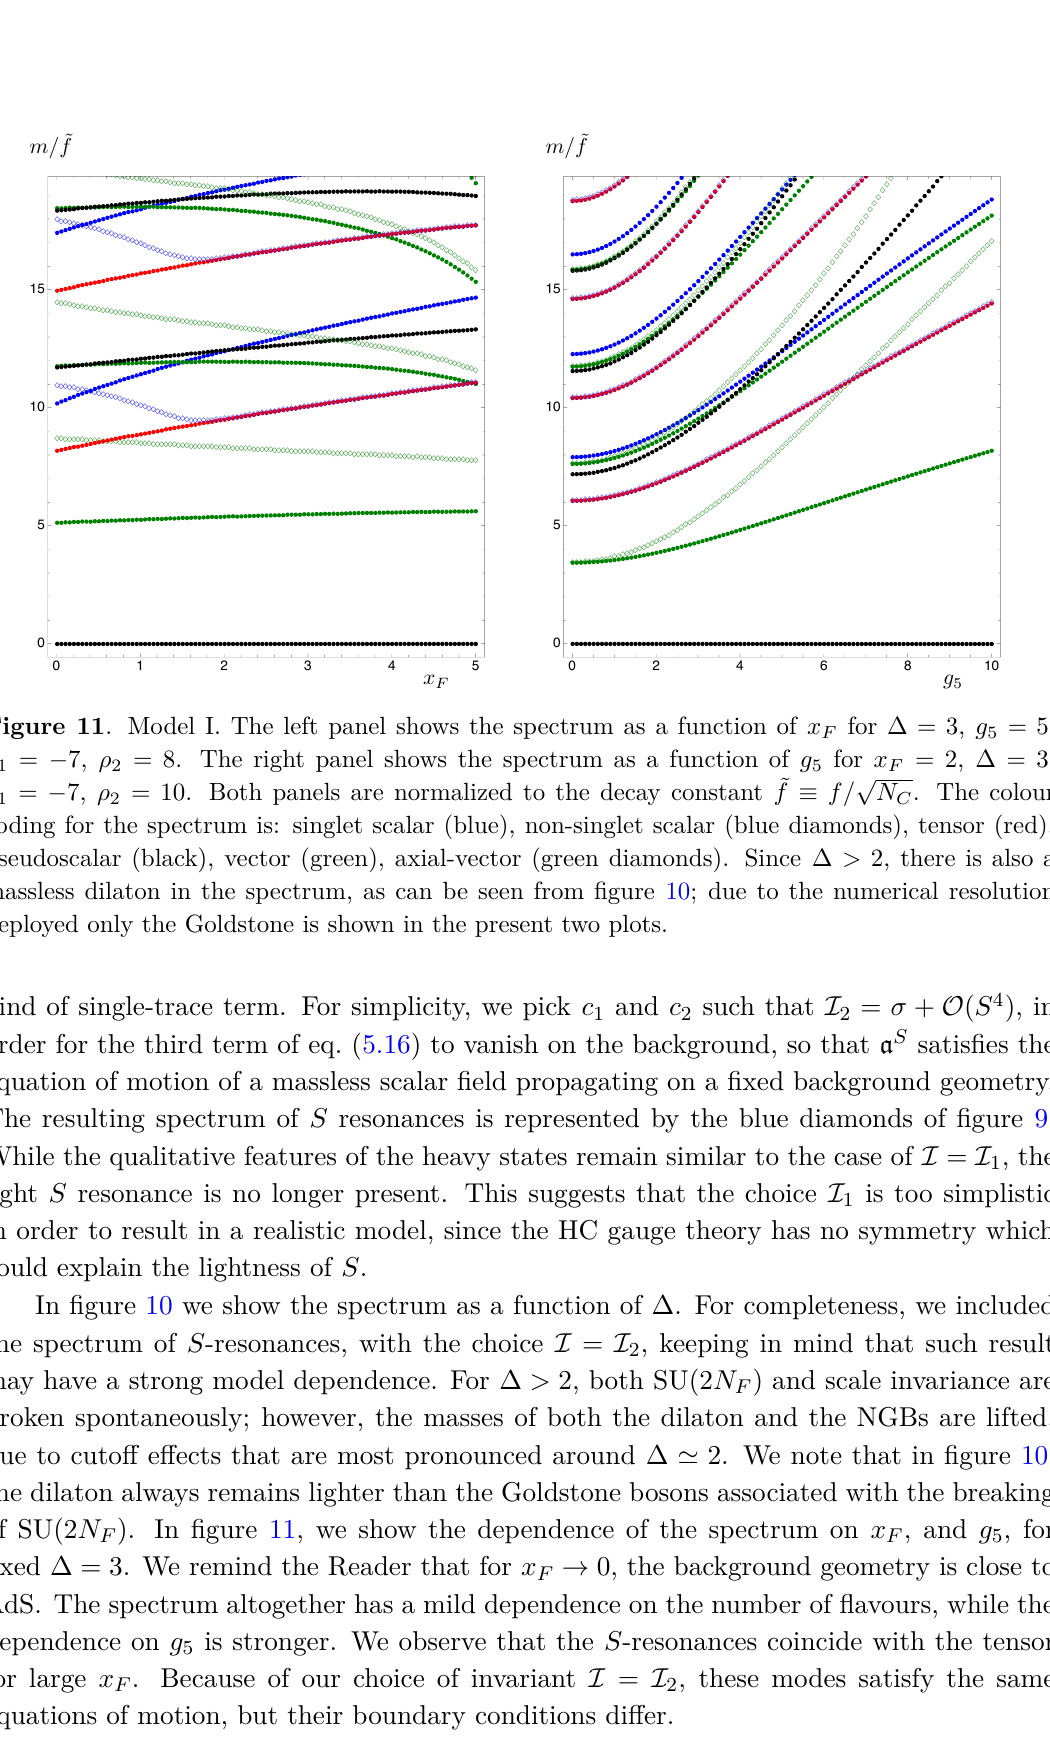
√ ˜ f ≡ f/ N C . The colour